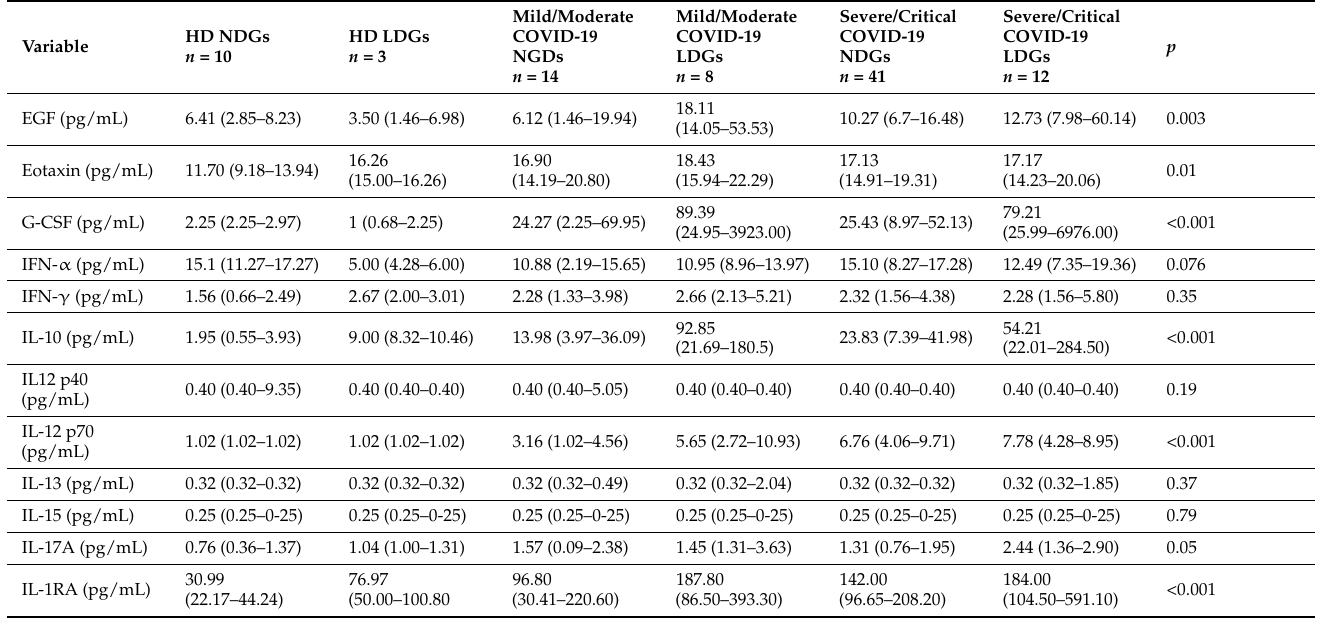
Figure 6. Heat map of the expression of cytokines and chemokines after macrophages were stimulated with COVID-19 and healthy donor NETs. The proinflammatory response is mainly elicited by COVID-19 LDG (red box) and NDG NETs (yellow box), whilst none of the healthy donor NETs promoted the secretion of these cytokines and chemokines (green box). Heatmap based on hierarchical clustering by Ward’s method was constructed. Table 3. Differential expression of cytokines and chemokines in supernatant after macrophage stimulation with NETs.